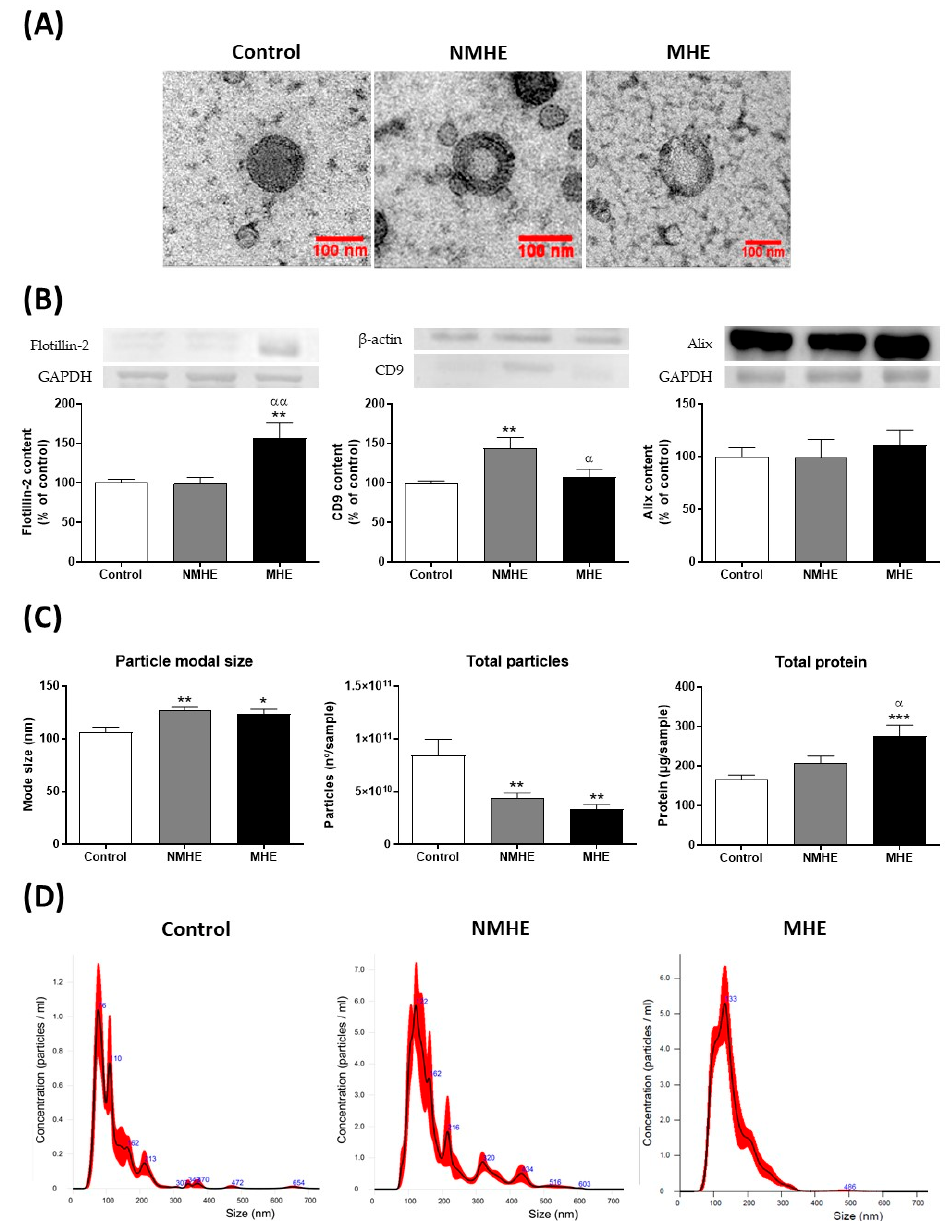
Figure 1. Characterization of extracellular vesicles isolated from the plasma of the control and patients without and with MHE. ( A ) Representative images obtained by transmission electron microscopy after negative staining. ( B ) Content of markers Flotillin-2, CD9, and Alix analyzed by Western blot; β -actin or GAPDH were used as the loading controls. ( C ) Particle size mode (nm), total particles per sample measured by nanoparticle tracking analysis, and total protein ( µ g/sample) in EVs. The total particles and total protein of EVs were referred to the initial volume of plasma used to isolate EVs (5 mL), the same for all samples. Values are the mean ± SEM of 10–25 samples per group. Data were analyzed by univariate analysis of covariance (ANCOVA) with age included as a covariate, followed by the Tukey post hoc test. ( D ) Example of the particle size distribution profiles measured by NTA in the three groups of study. NMHE, MHE, patients without and with minimal hepatic encephalopathy, respectively. Values significantly different from the control are indicated by an asterisk (*) and from NMHE patients by α (*/ α : p < 0.05; **/ αα : p < 0.01; ***: p < 0.001).